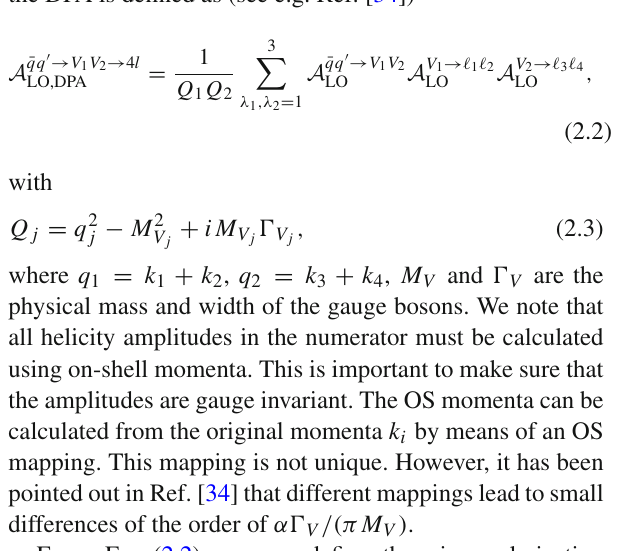
Fig. 1 Doubly resonant diagrams at leading order